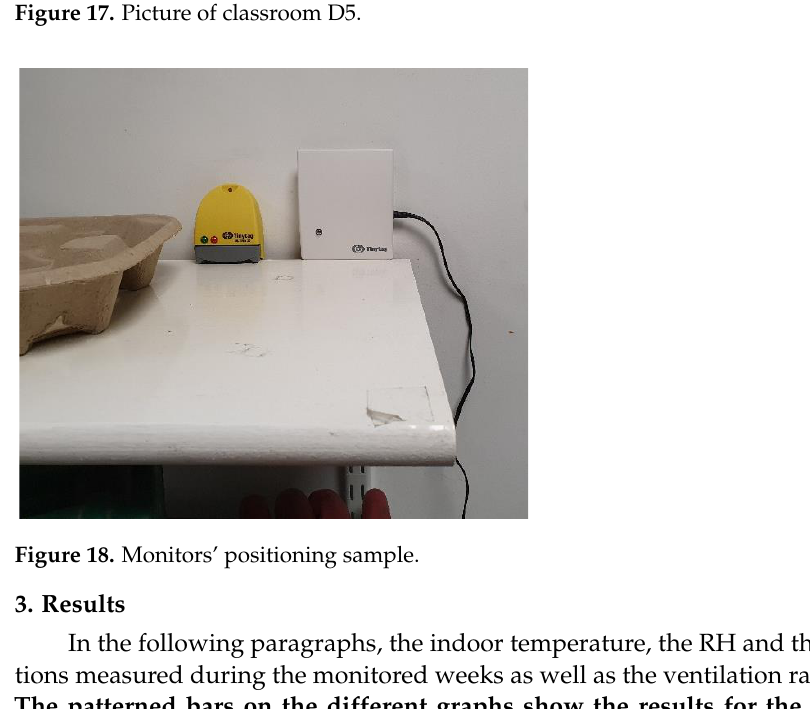
Figure 18. Monitors ’ positioning sample.